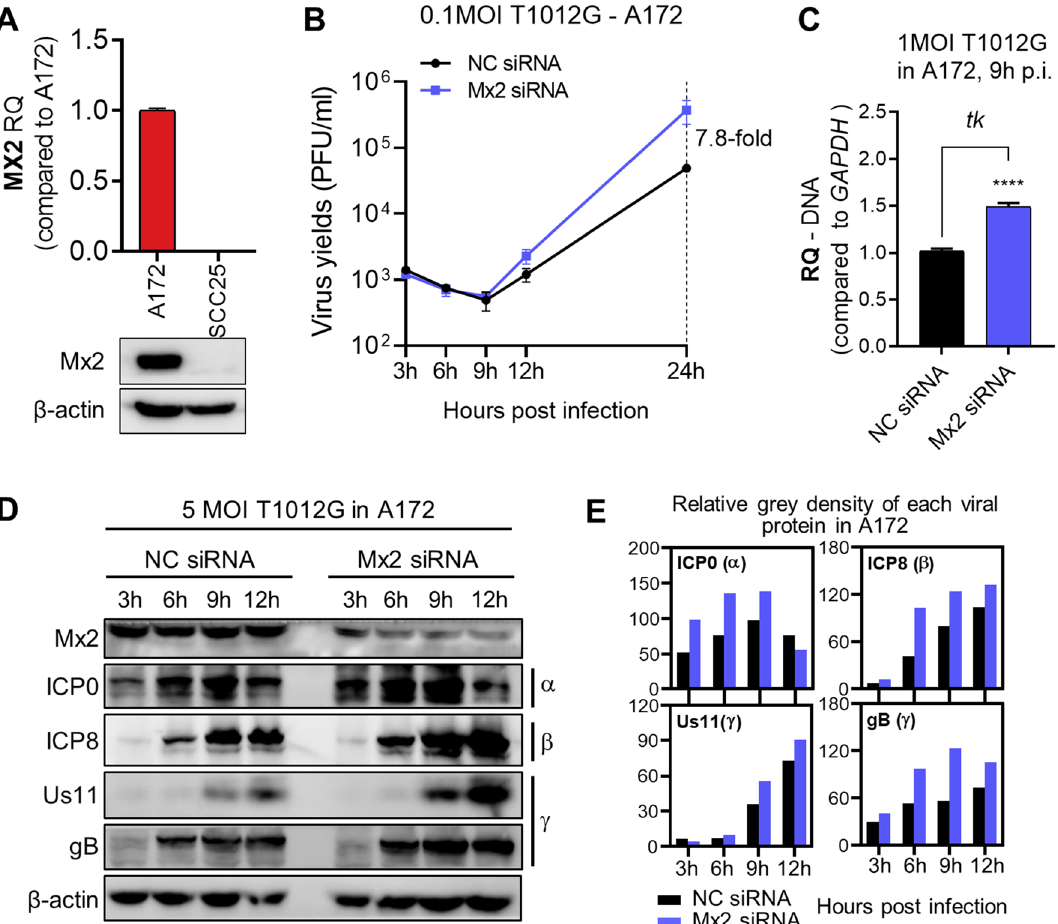
Figure 2. Depletion of Mx2 in resistant A172 cells enhanced oHSV-1 T1012G lytic replication. ( A ) mRNA accumulation of Mx2 in A172 and SCC25 cells. ( B ) Virus yields in Mx2-depleted A172 cells. Virus progeny were harvested at the indicated time and titrated in Vero cells. ( C ) Viral DNA copy numbers in Mx2-depleted A172 cells. Viral DNA was isolated and analyzed by the qPCR assay. Primers set of ICP0 and tk were used to detect DNA copies. RQ: relative quantity, normalized to GAPDH DNA. ( D ) Expression of viral proteins in Mx2- depleted A172 cells at indicated time points post 5 MOI T1012G infection. Blots were cut and probed with ICP0 (α); ICP8 (β); Us11, gB (γ) or β-actin antibodies, respectively. β-actin serves as a loading control. ( E ) The band density of viral protein was measured by the grey analysis. Relative density was normalized to